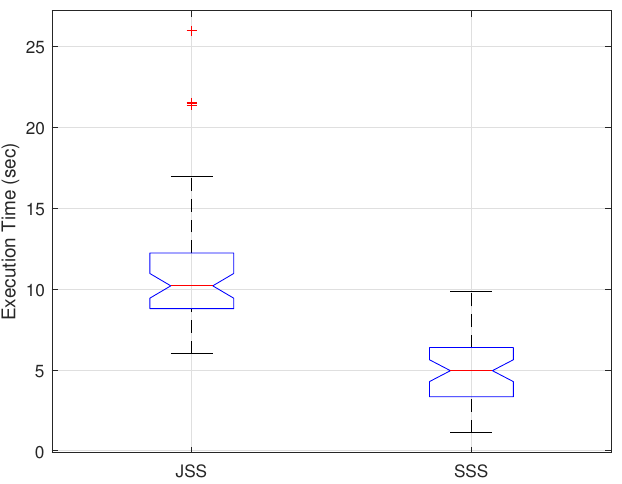
Figure 9. Variation in the execution time of the SSS and the JSS considering the